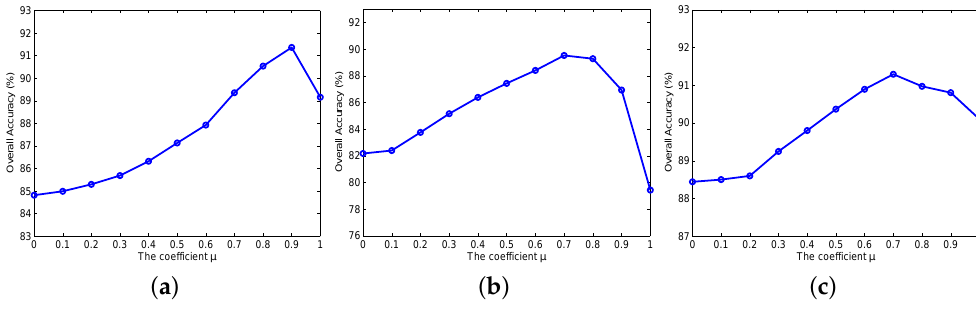
Figure 10. The OA versus the weighting coefficient µ : ( a ) IP; ( b ) UP; ( c )